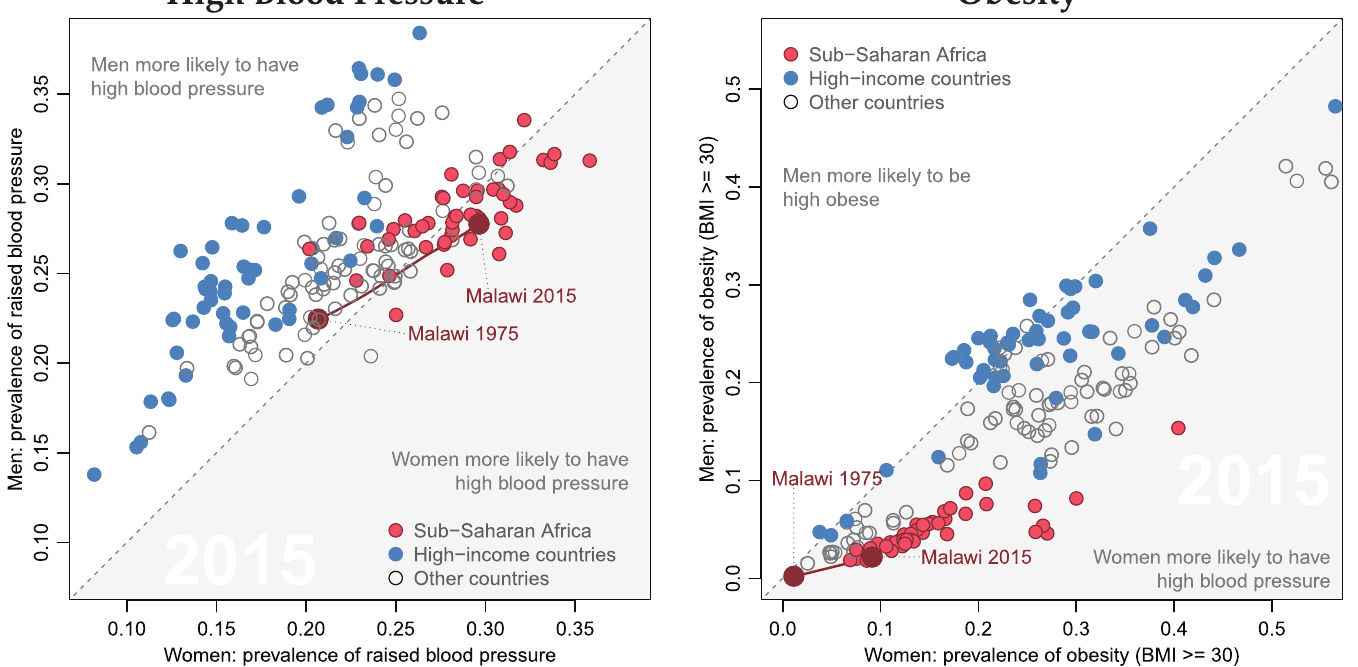
Fig 1. Prevalence of high blood pressure and obesity by sex across different regions in the world (2015, in %, age-standardized). Source : Own calculations based on NCD-RisC [1]. High blood pressure is defined by NCD-RisC as systolic BP � 140 mmHg or diastolic BP � 90 mmHg. Obesity is defined as BMI � 30. Prevalence of high blood pressure and obesity are age-standardized so that they are better comparable across